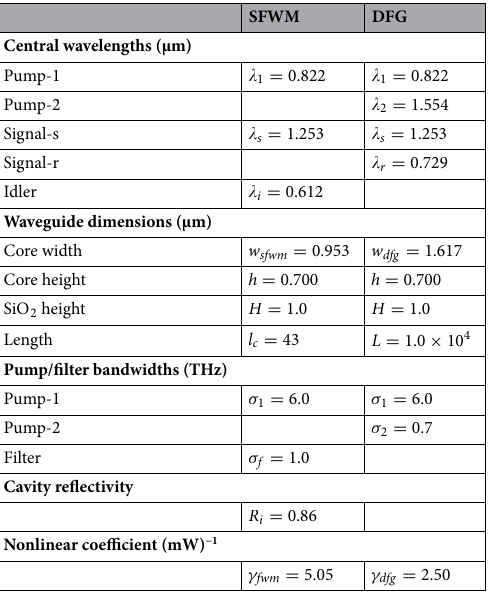
Table 1. Parameters of the SFWM and DFG sources of the proposed integrated photonic